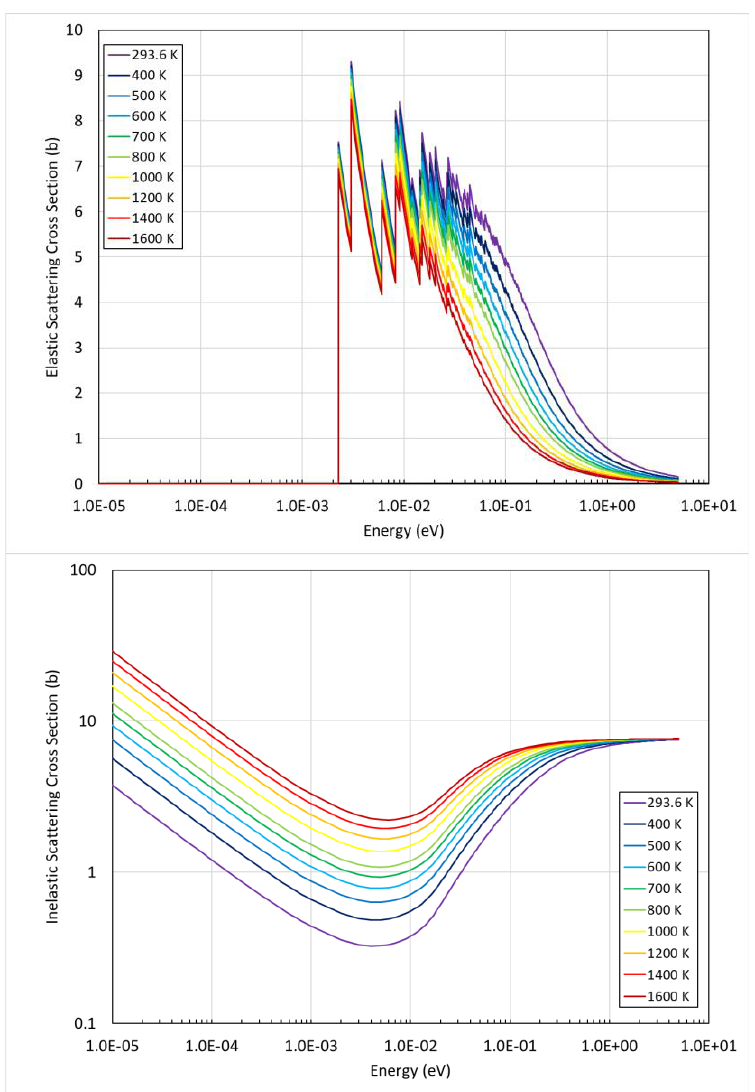
Figure 4. Y-YH Coherent Elastic (top) and Incoherent Inelastic (bottom) Scattering Cross 2